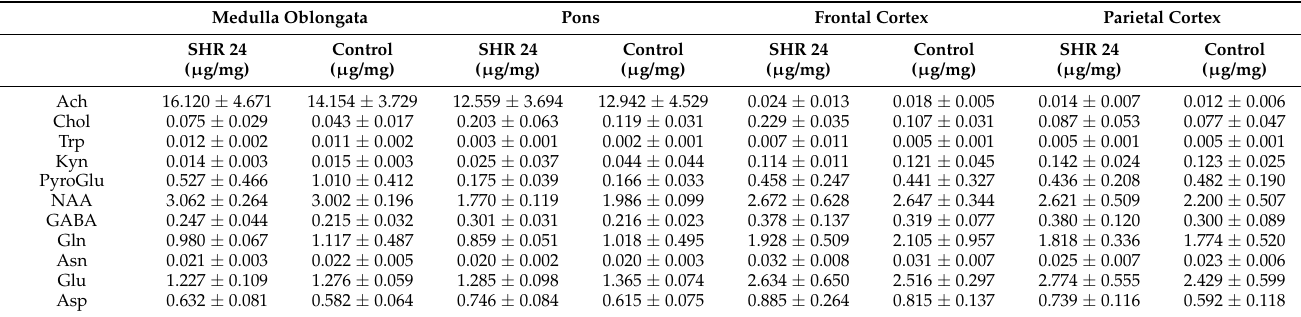
Table 5. Brain tissue concentrations of NT, tryptophan and kynurenine in different parts of brain. Data are presented as mean ± standard deviation